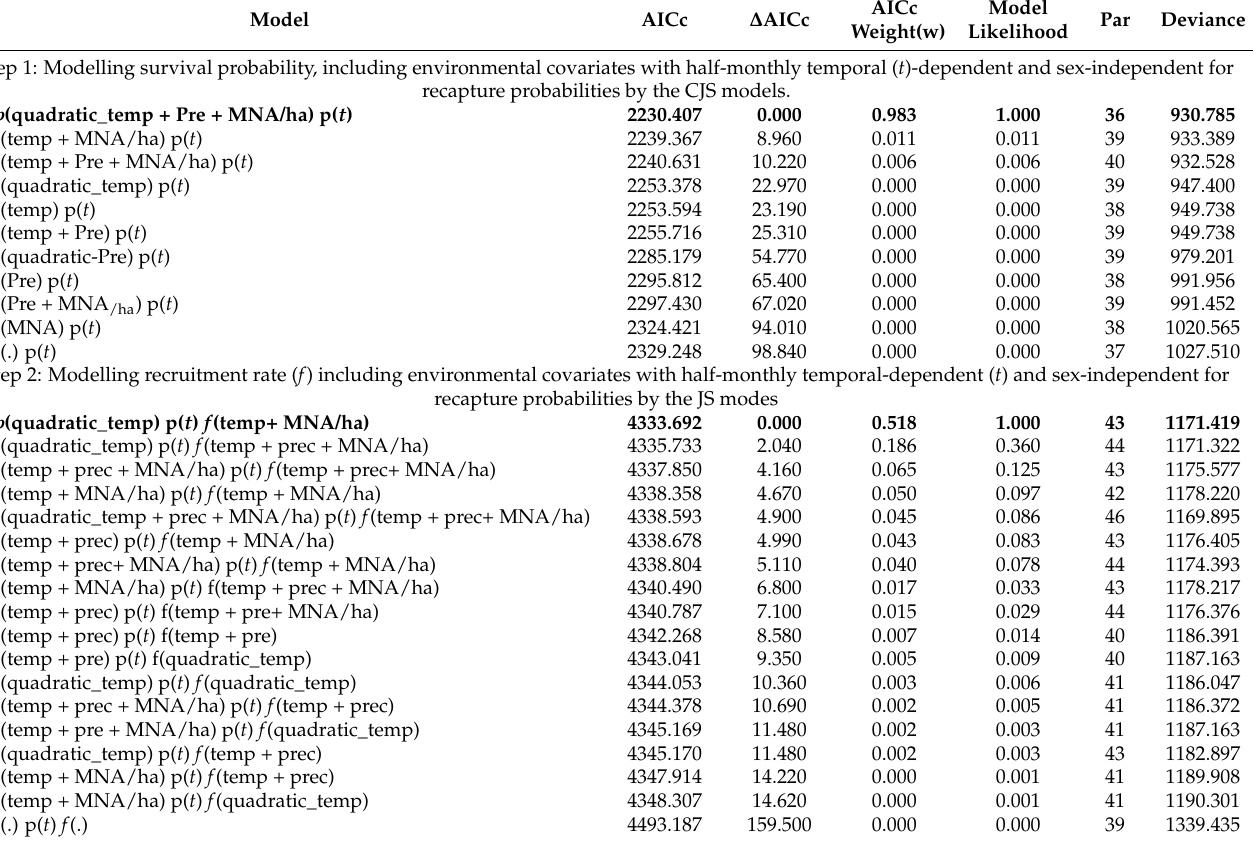
Table 1. Complex effects of temperature ( ◦ C), precipitation (mm) and population density on survival ( ϕ ) using the Cormack–Jolly–Seber (CJS) models or survival ( ϕ ) and recruitment rate ( f ) using the Jolly–Seber models for Mongolian gerbils ( Merionus unguiculatus ) in Houhatai, Inner Mongolia, China, from April 2014 to September 2017. Model AICc ∆ AICc